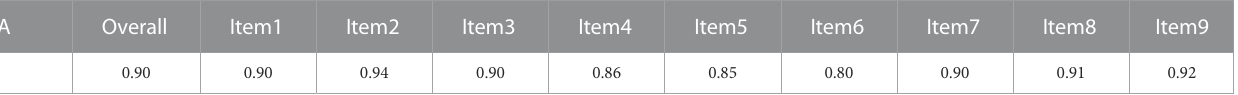
TABLE 4 KMO measure of sampling adequacy (N =